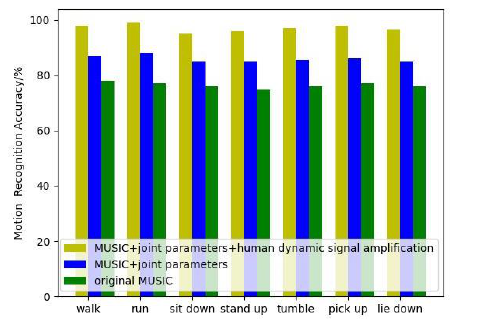
Figure 6. Comparison diagram of action speed distribution